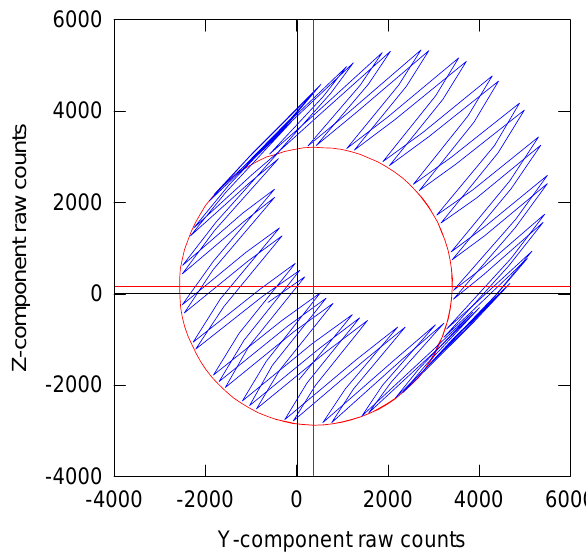
Fig. 6. Plot of the two spin plane components of the (raw) magnetic field data prior to and during the application of the calibration signal (in blue). The circle (in red) represents the ambient magnetic field measured by the two sensor axes; the offset of the circle from the origin represents the offsets of these two